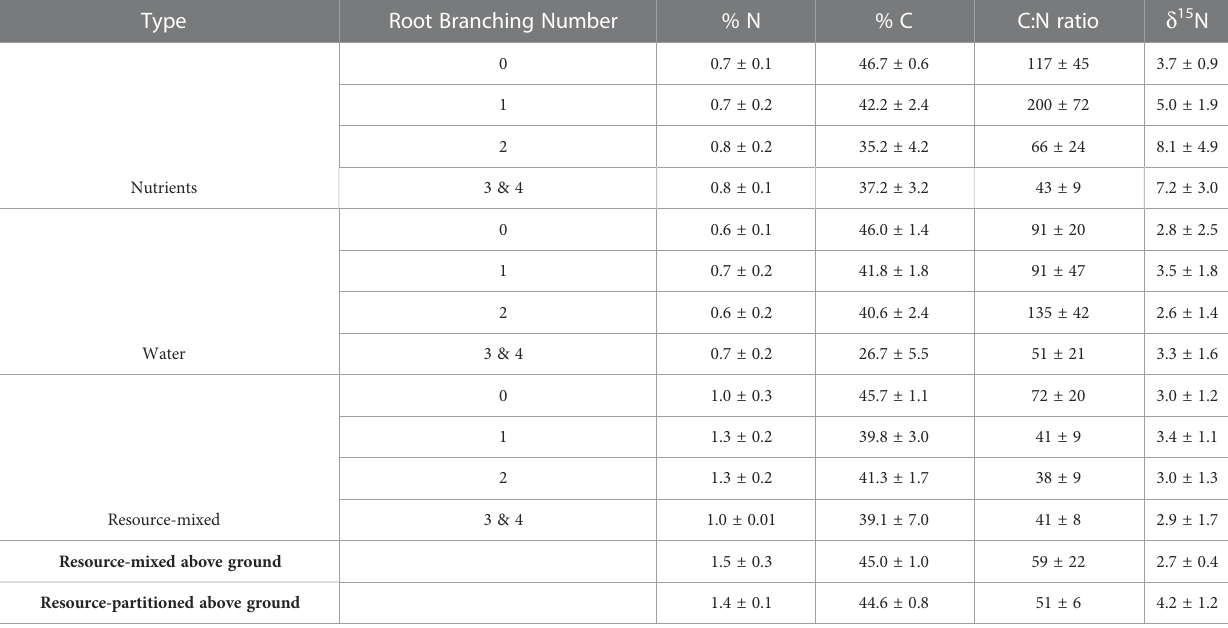
TABLE 3 Nitrogen (N) and Carbon (C) content (%), C:N ratios, and d 15 N ( ‰ ) of P. virgatum root tissues, separated by branching number as well as total above-ground plant tissues (mean ± SEM).